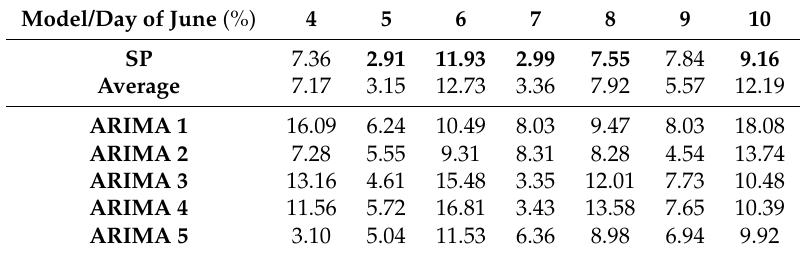
Table 5. Daily average error (%) of 4–10 June 2016, for the SP model, average, and ARIMA Models 1–5. Model/Day of June (%)